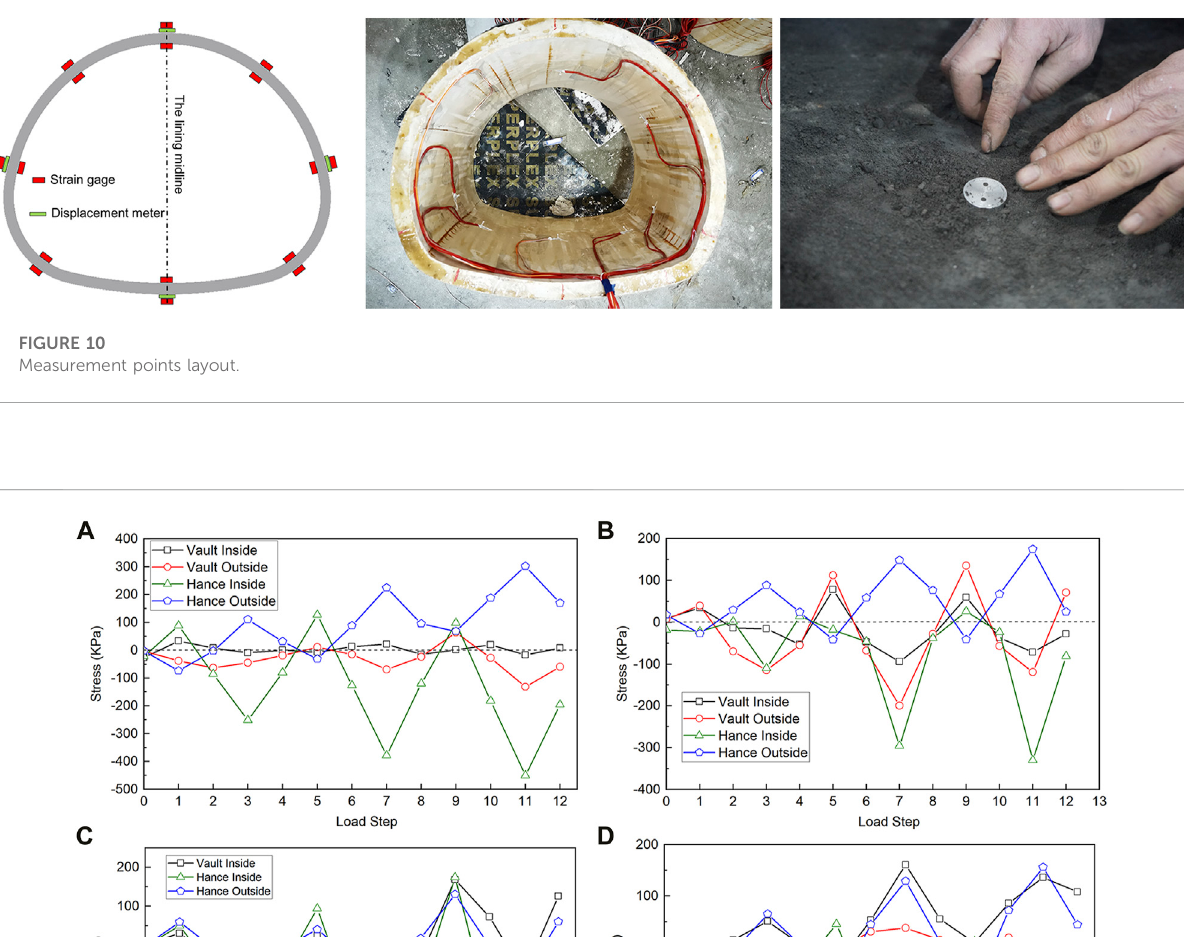
Frontiers in Earth